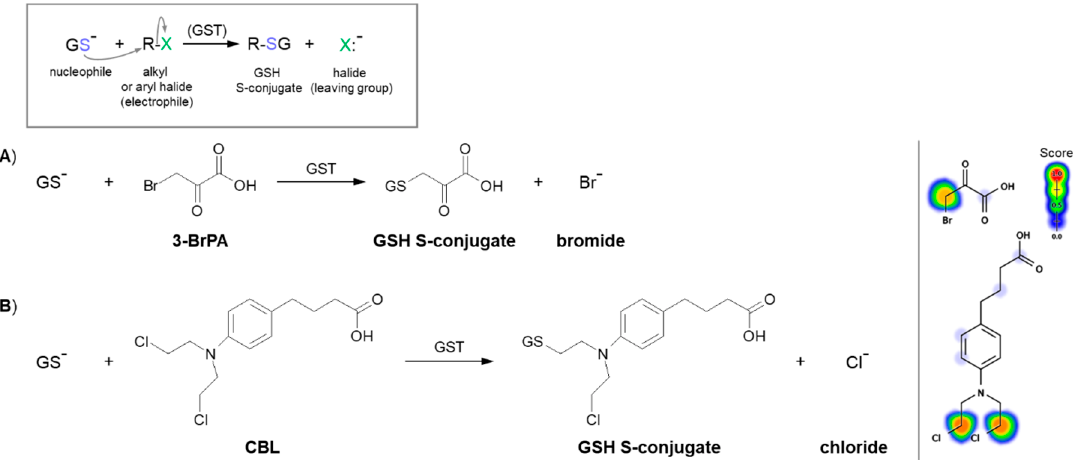
Figure 5. Reaction schemes of nucleophilic substitution of the thiolate anion of GSH (GS – ) to the halogen atom (leaving group) in ( A ) 3-bromopyruvic acid (3-BrPA) [17] and ( B ) chlorambucil (CBL) [65]. The frame shows the general scheme of the GSH conjugation reaction. Predicted bioactive sites of GSH conjugation for anticancer drugs were obtained by XenoSite Reactivity Predictor available at https://swami.wustl.edu/xenosite/p/reactivity (accessed on 18 May 2022).